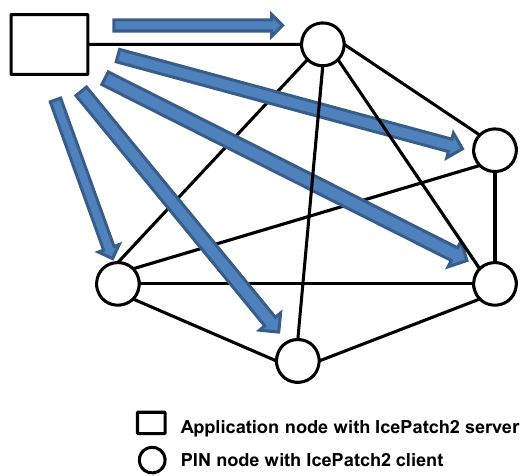
Figure 2. Code deployment